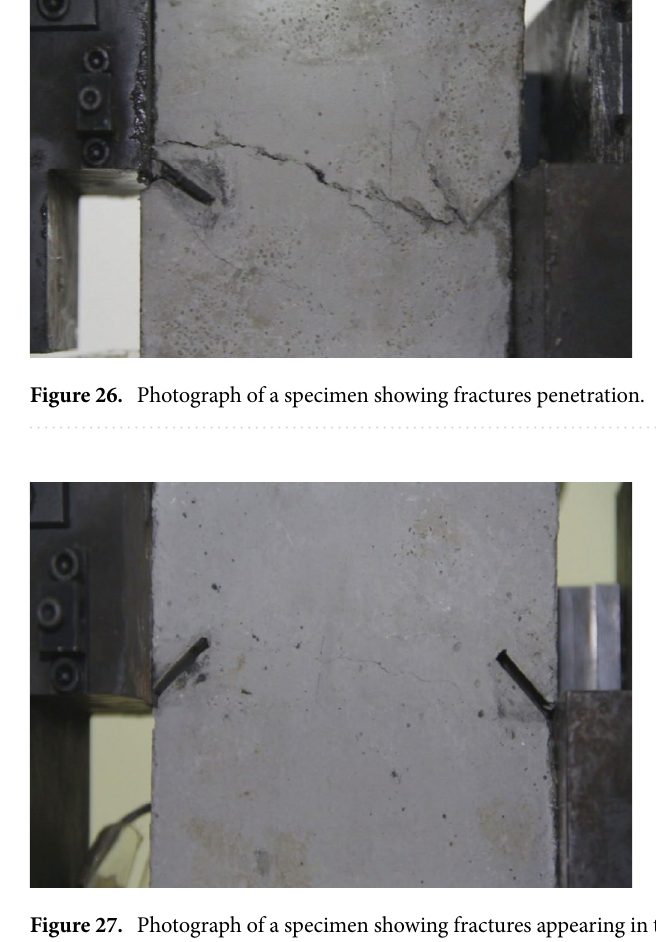
Figure 27. Photograph of a specimen showing fractures appearing in the middle of the rock mass.